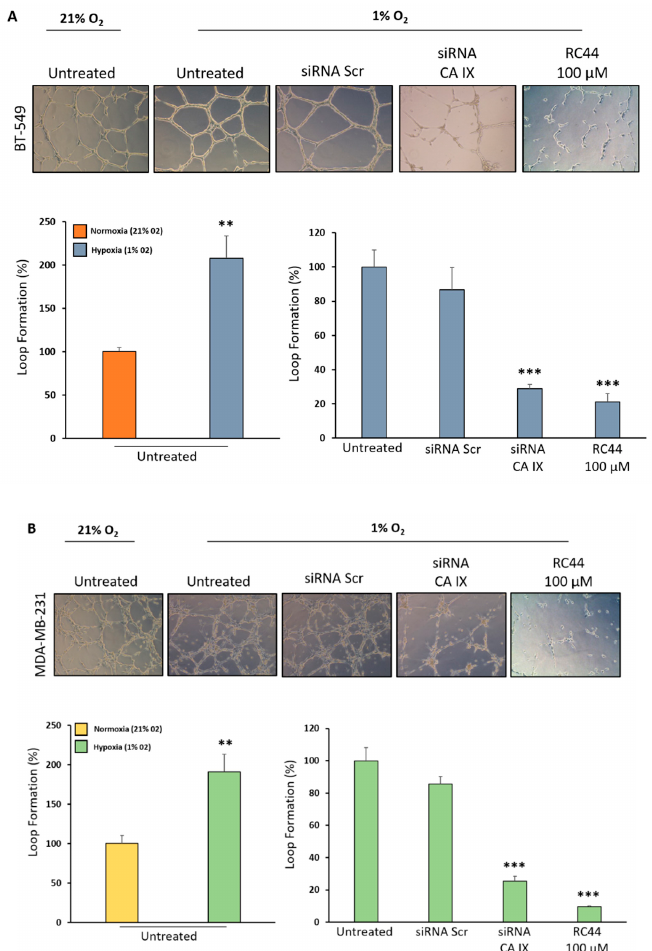
Figure 2. Targeting CA IX reduces TNBC vasculogenic mimicry. BT-549 ( A ) and MDA-MB-231 ( B ) were grown in normoxia (21% O 2 ) or hypoxia (1% O 2 ) conditions on the surface of Matrigel and vascular loops were analyzed. TNBC cell grown in 1% O 2 were transfected with siRNA CA IX (100 nM) and siRNA Scr (100 nM) for 48 h or treated with RC44 (100 µM) and seeded into 24-well plates pre-coated with 80 µL/well Matrigel. Representative images were taken at 10× and the average of the number of complete loops was calculated from 3–5 random fields by a macro made with ImageJ software. Bars depict mean ± SD of three independent experiments. *** p < 0.0001; ** p < 0.001.